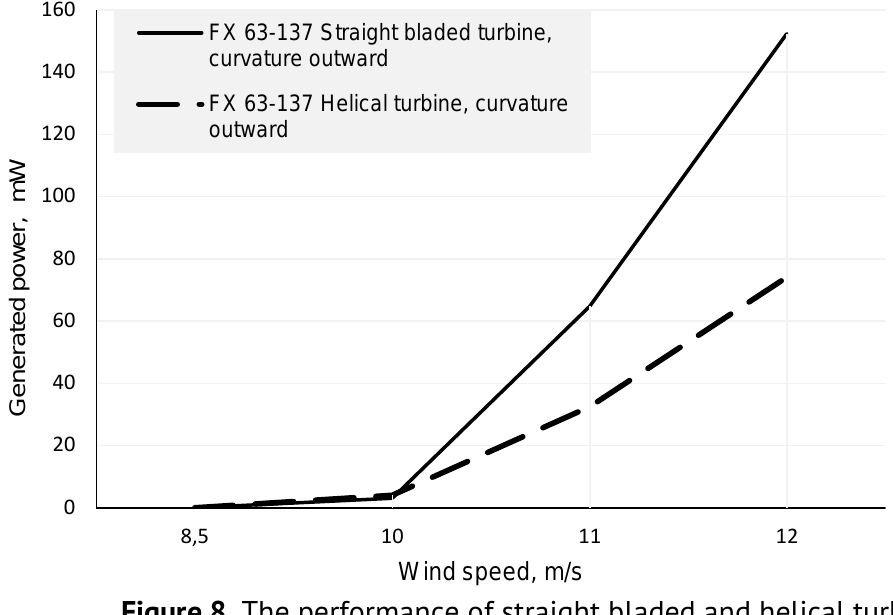
Figure 8. The performance of straight bladed and helical turbines based on FX 63-137